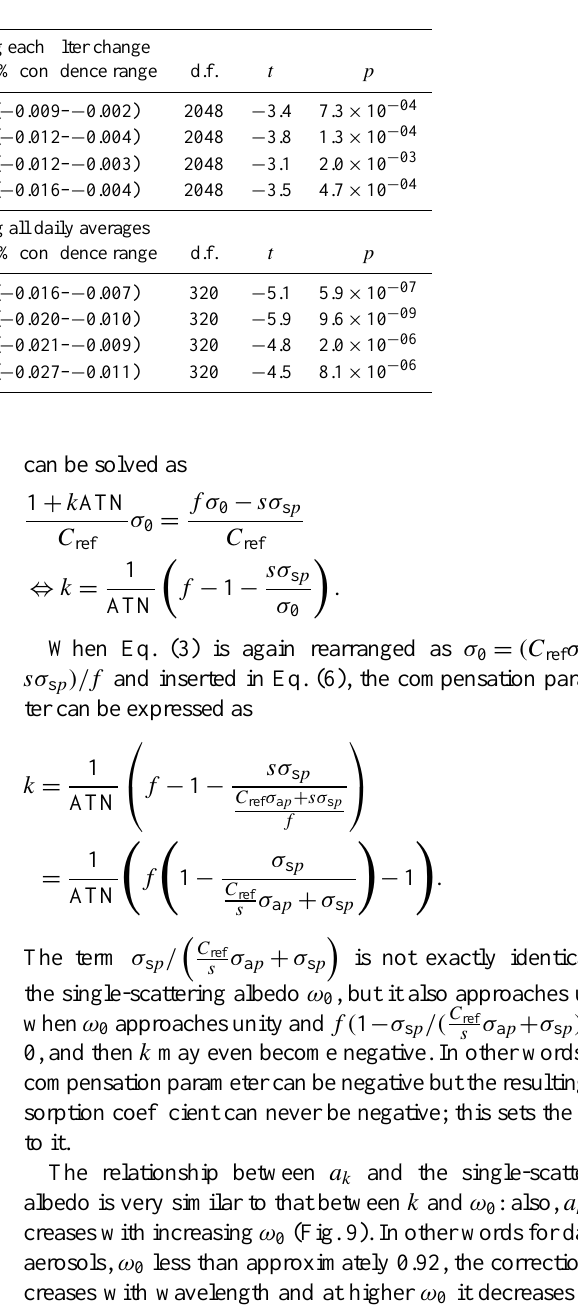
Table 2. Regression statistics ( y = β 1 x + β 0 ) of compensation parameter vs. single-scattering albedo. Detailed column description as in Table 1.